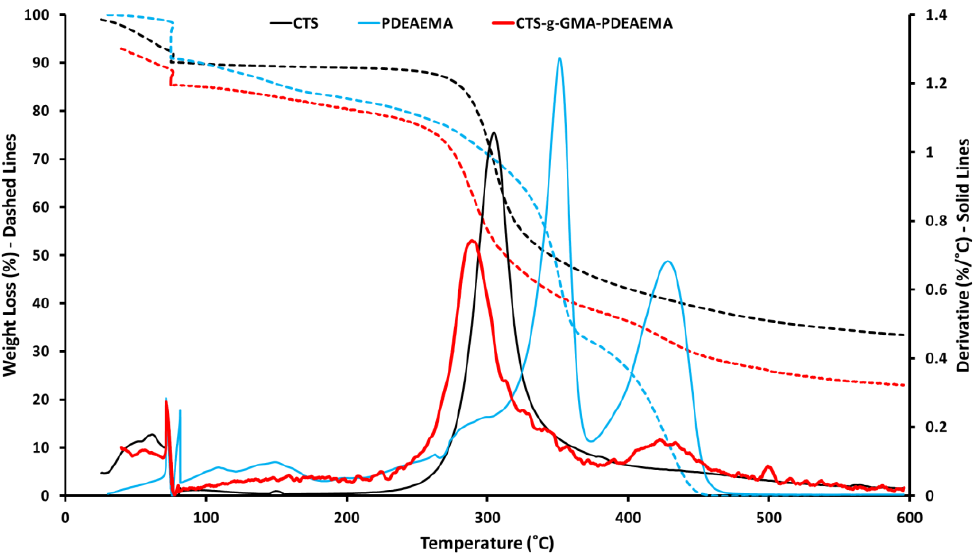
Figure 4. Thermogravimetric analysis (TGA) traces for pure and grafted chitosan.